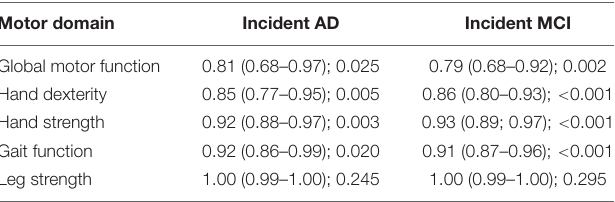
TABLE 3 | Associations of global motor function and each individual motor domain with incident AD and incident MCI (HR: 95% CI; p -value). Motor